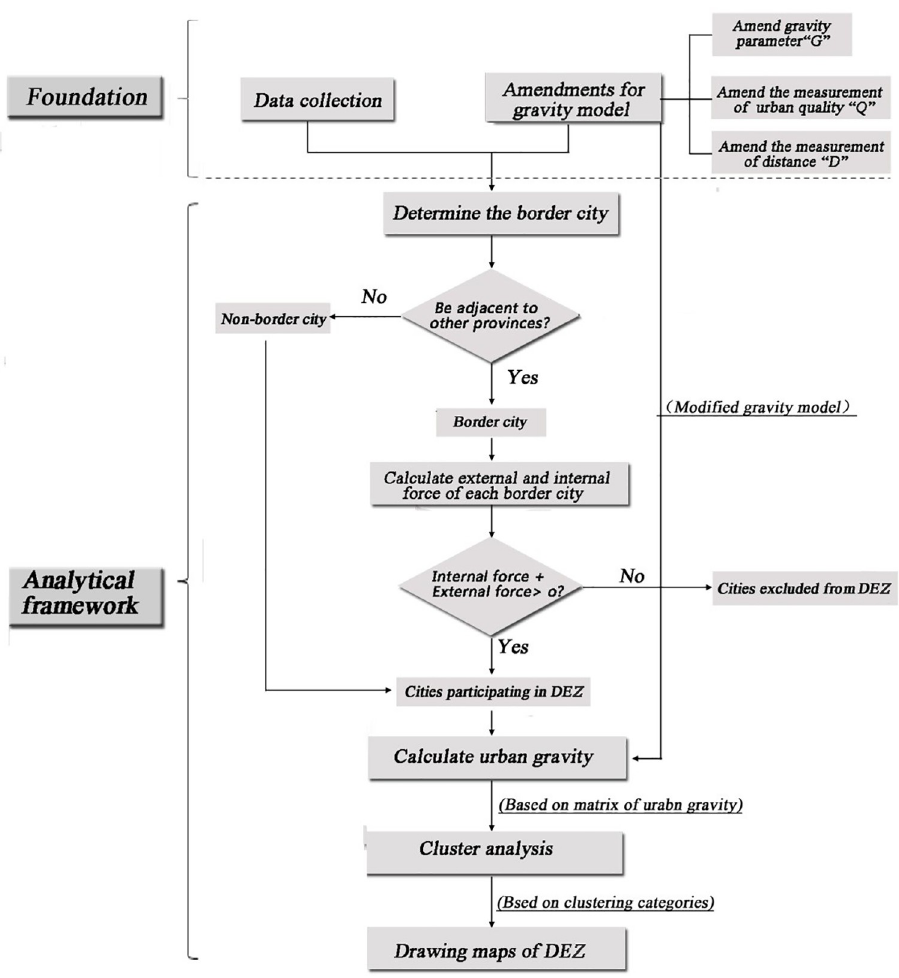
Fig 1. Flow chart of the analytical